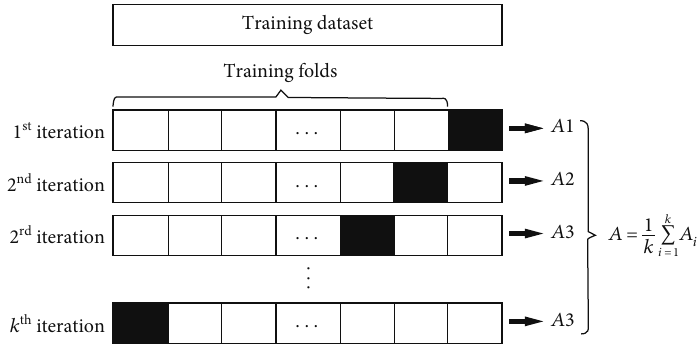
Figure 13: Schematic diagram of